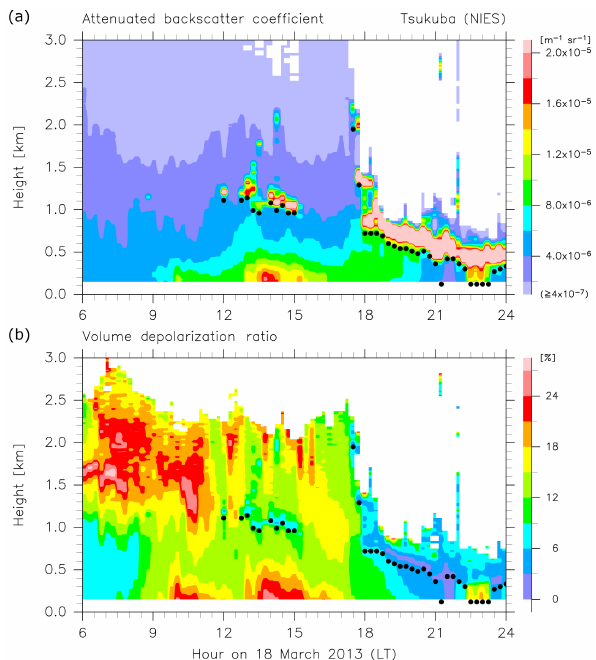
Figure 5. Time–height distributions of attenuated backscatter coef- ficient at 532nm (top) and volume depolarization ratio at 532nm (bottom) measured with a lidar system at Tsukuba (36.05 ◦ N, 140.12 ◦ E) between 06:00 and 24:00LT on 18 March 2013. See Shimizu et al. (2004) for the definition of the depolarization ratio. Small depolarization ratios (e.g. < 5%) indicate that particles are spherical. Temporal resolution is 15min, and vertical resolution is 30m, with the lowest 120m portion of the data not shown because of large uncertainty. For the depolarization ratio plot, data points whose 532nm backscatter coefficient is < 1 . 0 × 10 − 6 m − 1 sr − 1 are not shown. Also shown with dots in both panels are the cloud base location estimated from the 1064nm lidar measurements (i.e. the lowest level where vertical gradient of 1064nm attenuated backscatter coefficient exceeds 1 . 2 × 10 − 6 m − 1 sr − 1 per 60m and the maximum attenuated backscatter coefficient in the cloud layer must exceed 2 . 0 × 10 − 5 m − 1 sr − 1 , with apparent cloud top where attenuated backscatter coefficient value becomes equal to that at the cloud